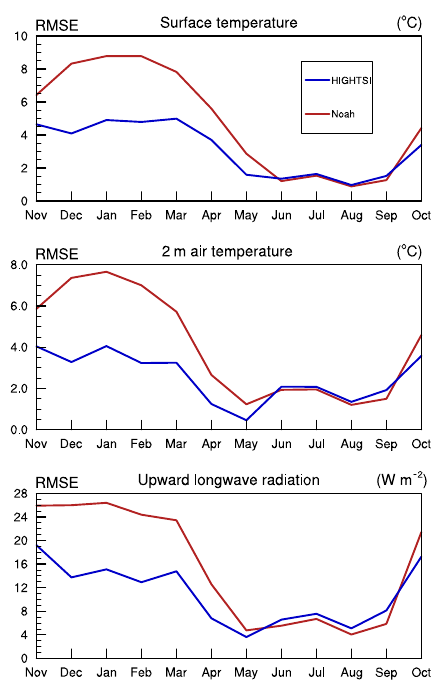
Figure 6. RMSE of surface temperature, 2m air temperature and upward long-wave radiation for WRF-Noah and